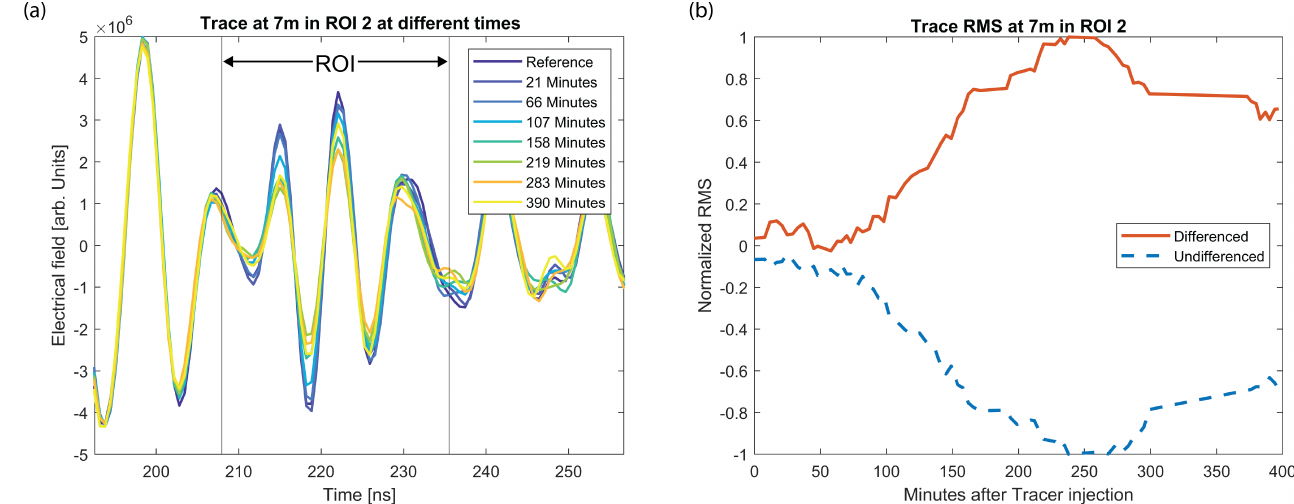
Figure 11. ( a ) GPR traces at different times after tracer injection. The vertical lines indicate the limits of ROI 2. ( b ) Normalized RMS( E m ) of this monitoring trace in ROI 2 (dashed blue) in comparison with the difference RMS( E m − E r ) (solid